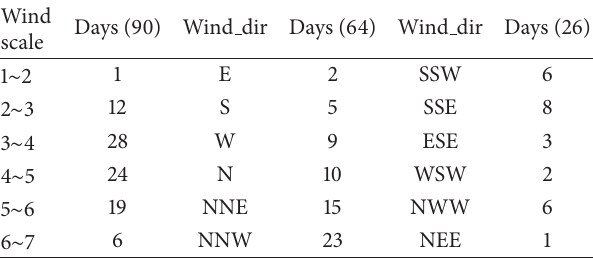
Table 2: Characteristics of wind field at Y-B mixed zone in winter